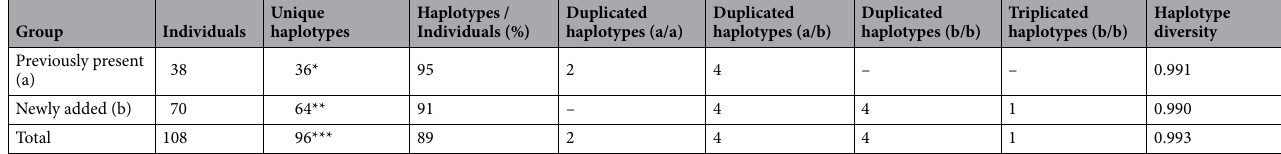
Table 3. The number of D-loop haplotypes determined based on UMI-assisted HaCeD-Seq. a/a, a/b and b/b indicate duplicated or triplicated haplotypes in the aquarium tank, the aquarium tank/vehicle tanks, and vehicle tanks, respectively. *Determined by NGS with the UMI tags from eDNA samples. **Determined by Sanger sequencing from tissue samples. ***Total number of haplotypes including previously present and newly added.